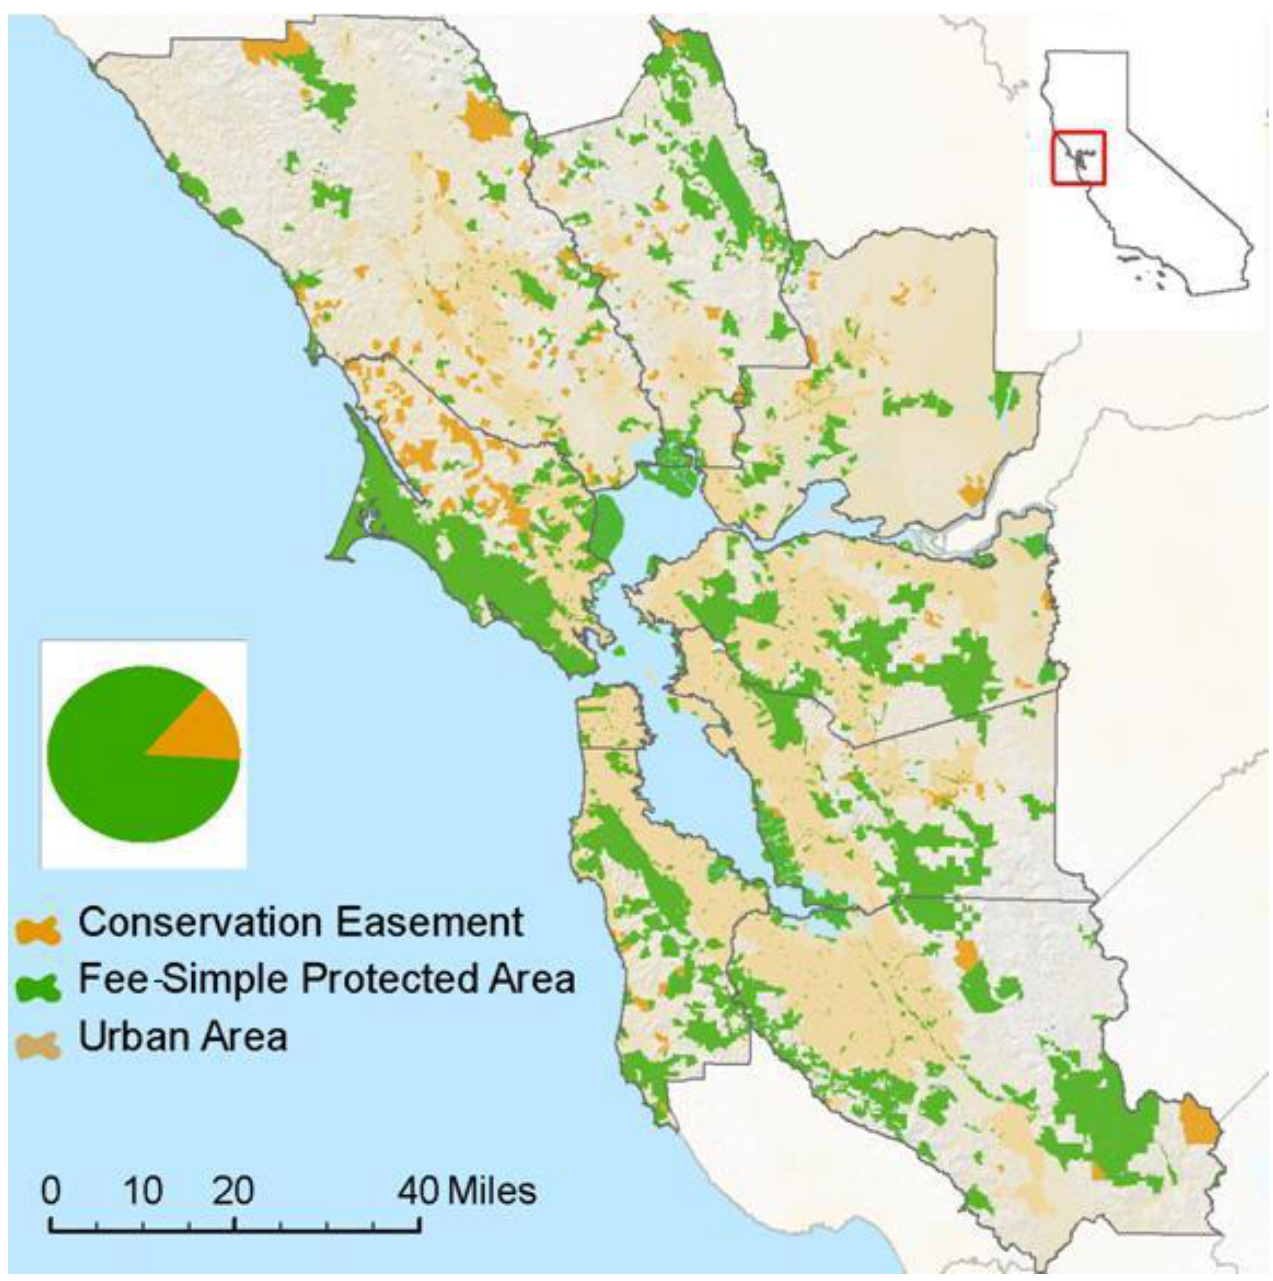
Fig. 2 . Conservation easements and fee-simple properties in the nine-county San Francisco Bay